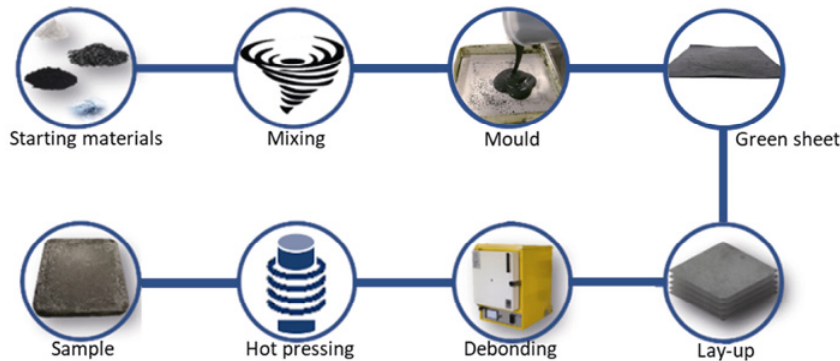
Fig. 1 Flow chart of the entire process: Starting materials are mixed, and then cast into a mould to obtain fibre/powder sheets, which undergo debonding in air, and then hot pressing to produce sintered